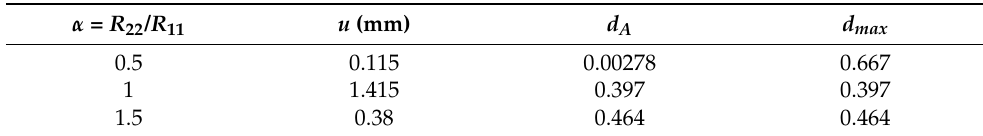
Table 3. Specified displacement and damage for different value of α